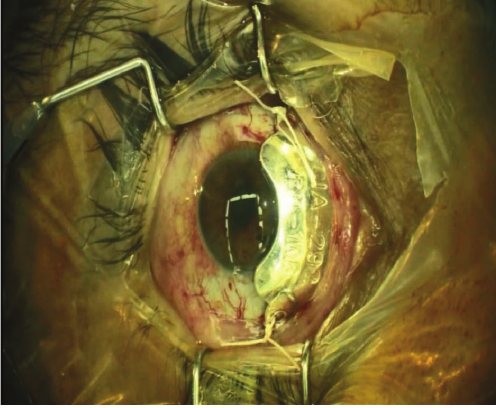
Figure 5. Ru-106 plaque (CIA design) to treat the iris tapioca